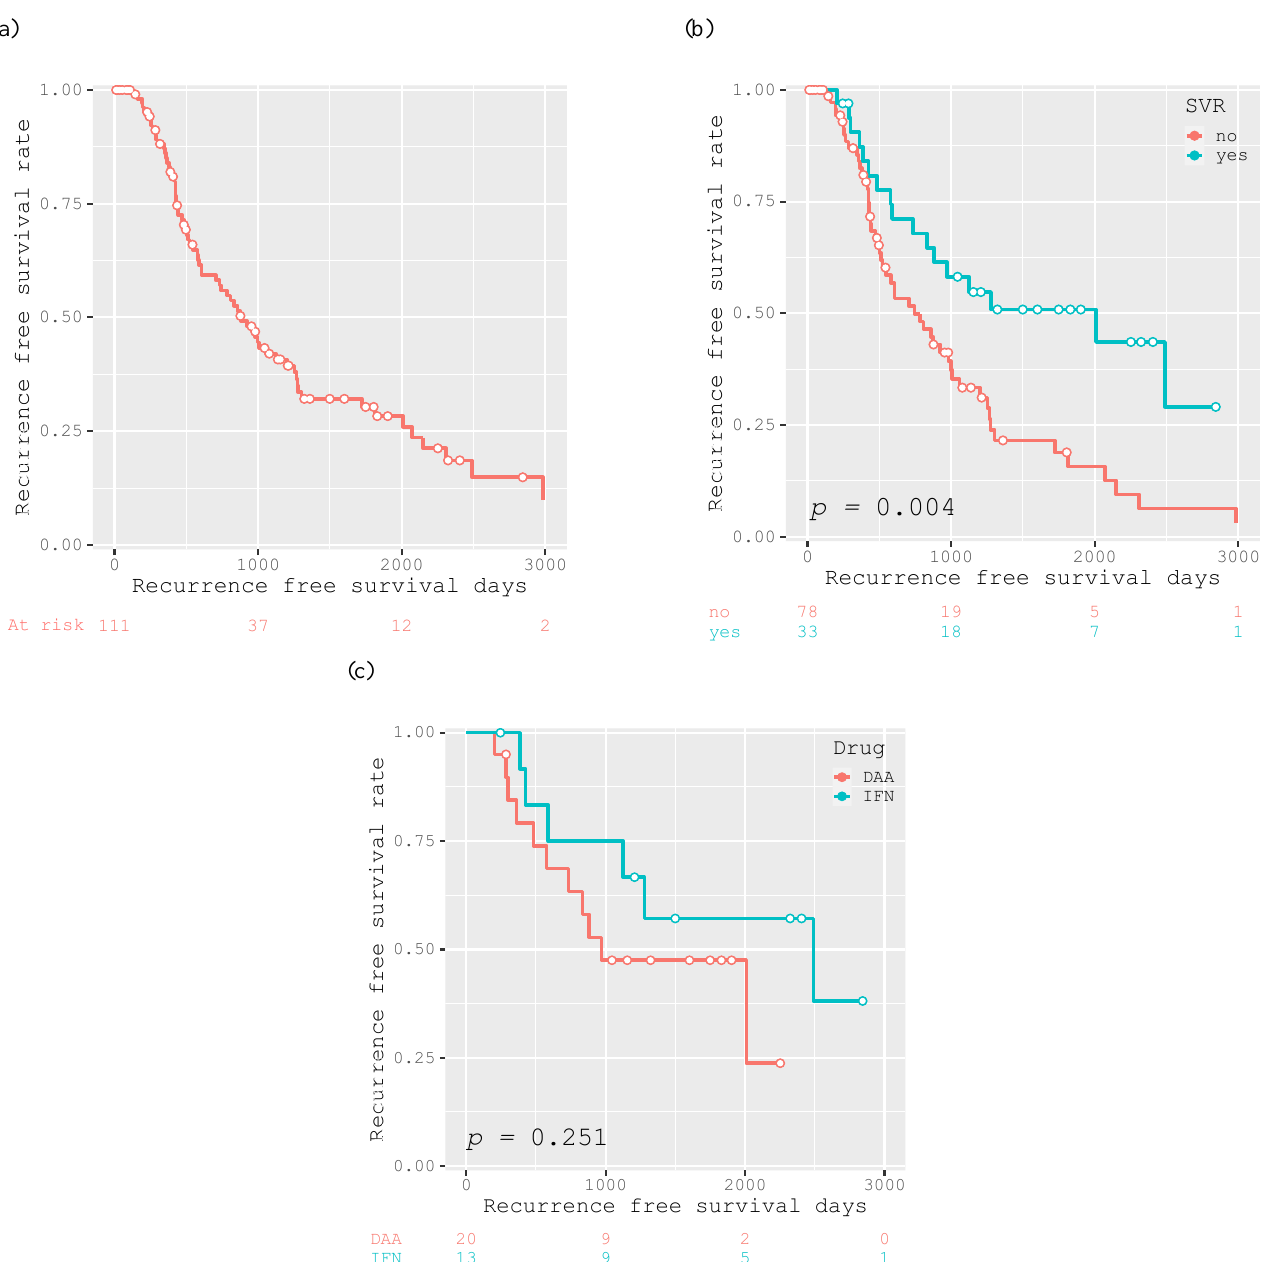
The 1-year, 3-year, and 5-year RFS rates of the participants were 84.0%, 42.0%, and 28.3%, respectively, and the median RFS was 882 days (Figure 4a). Patients who achieved SVR after curative treatment had a significantly longer recurrence-free survival than those who did not ( p = 0.004; Figure 4b). However, there was no significant difference in the RFS between patients who achieved SVR with DAA and IFN therapy ( p = 0.251; Figure 4c).